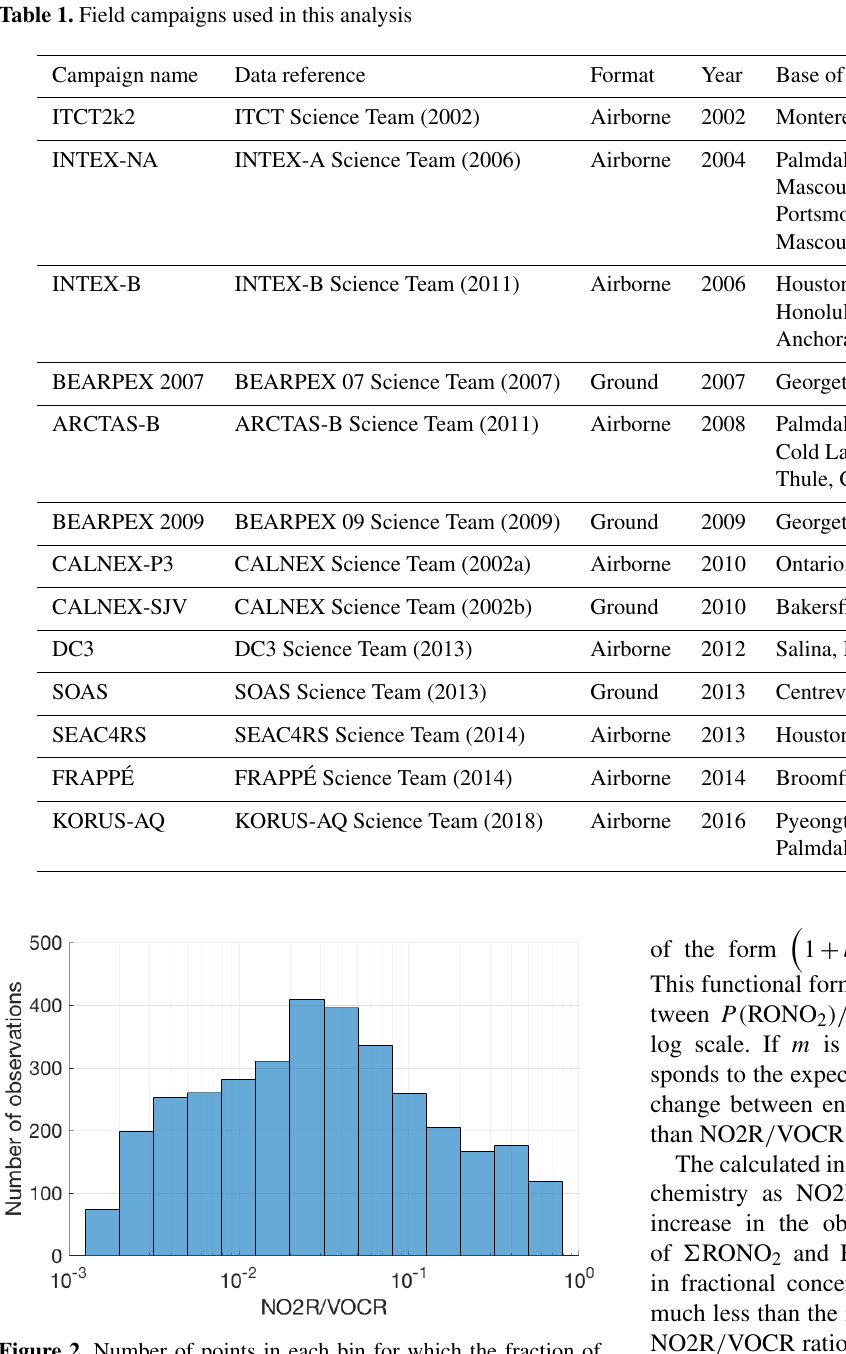
Figure 2. Number of points in each bin for which the fraction of NO x loss occurring via RONO 2 chemistry could be